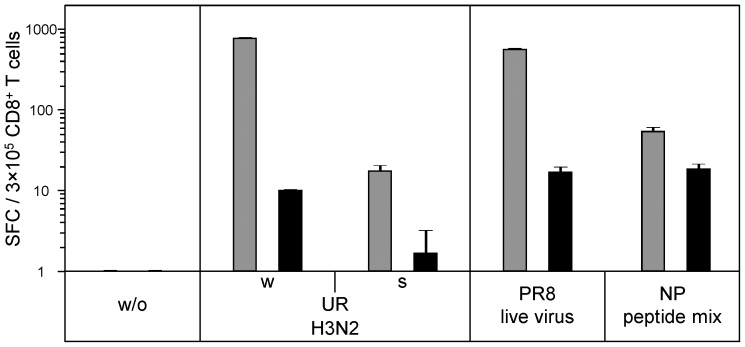
Proteasome inhibition strongly reduces CD8+ T-cell reactivity to whole virus vaccine.CD8+ T cells purified from PBMC of healthy donor HD21 were screened for IFN-γ ELISpot reactivity to autologous immature DC loaded with seasonal A/H3N2-Uruguay whole virus or split virus vaccines, or an influenza A/H3N2 nucleoprotein oligopeptide mix. Targets also included DC infected with live influenza virus of the Puerto Rico 8 lab strain. During loading or infection, respectively, DC were treated with epoxomicin (black columns) or DMSO solvent (grey columns), which both did not reduce cell viability in trypan blue staining. Data are representative of 3 experiments performed in different donors.